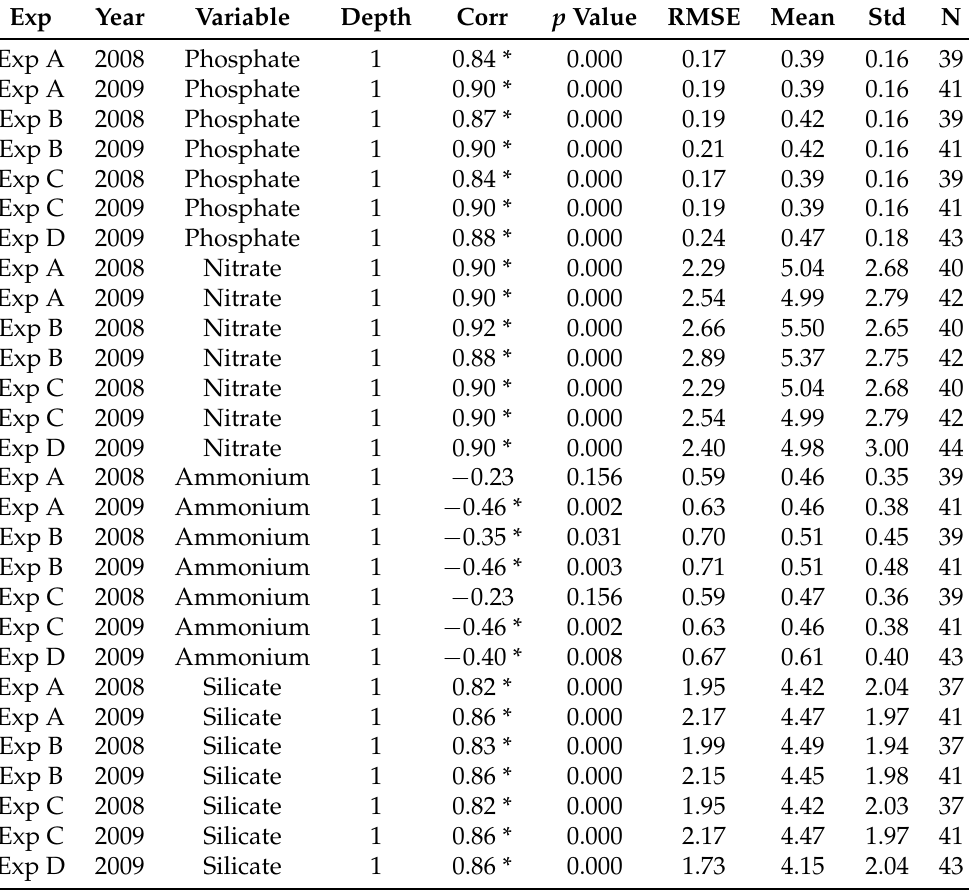
Table A3. Pearson correlations for experiments A–D, between observed and modeled variables for 2008–2009 at the shallowest depth available. Significant correlations at the 95% are indicated by